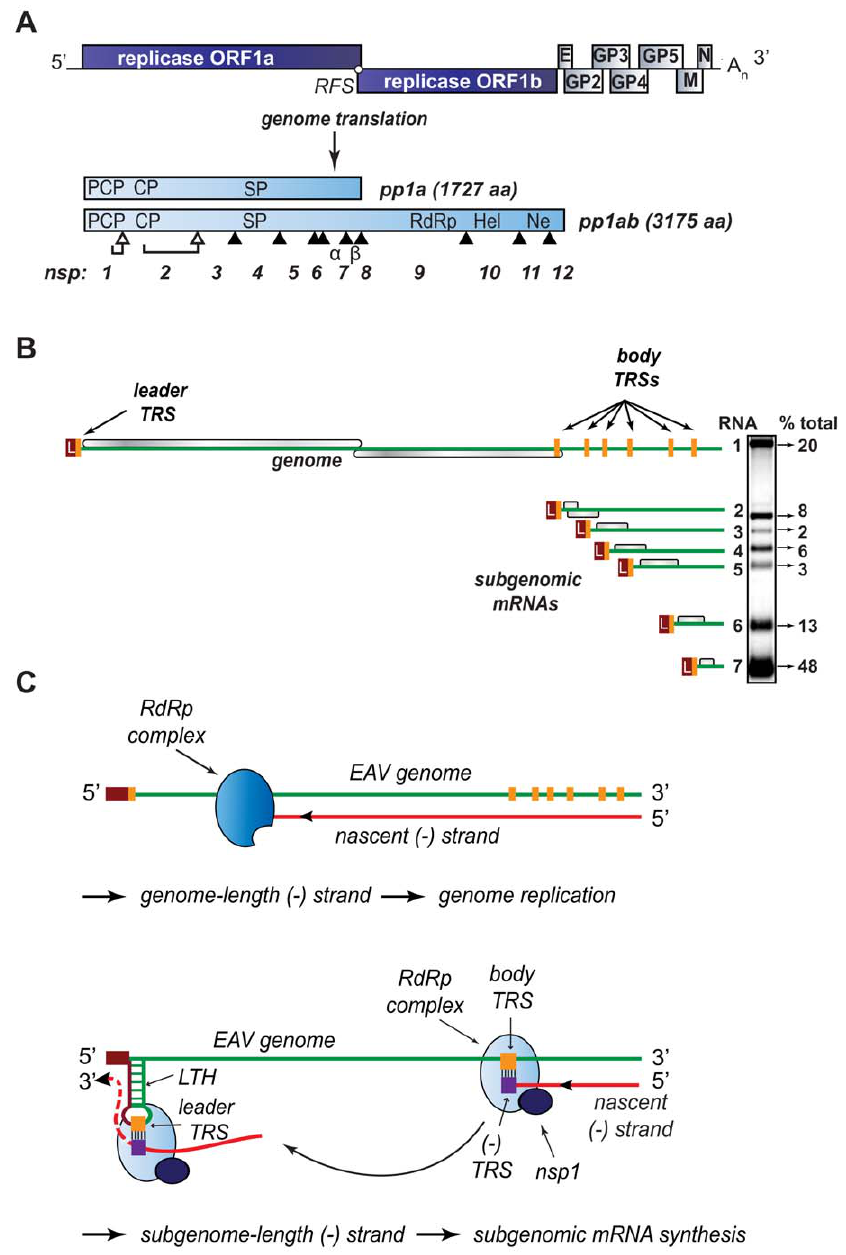
Figure 1. Organization and expression of the polycistronic EAV + RNA genome. (A) Top: EAV genome organization, showing the 5 9 - proximal replicase open reading frames (ORFs), as well as the downstream ORFs encoding the viral structural proteins envelope (E), membrane (M), nucleocapsid (N), and glycoproteins (GP) 2–5 and the 3 9 poly(A) tail (A n ). Bottom: overview of the pp1a and pp1ab replicase polyproteins that result from genome translation, which requires an ORF1a/1b ribosomal frameshift (RFS) to produce pp1ab. Arrowheads represent sites cleaved by the three virus-encoded proteases (open for autoproteolytically processed ones, closed for sites processed by the main proteinase in nsp4). The resulting nonstructural proteins (nsp) are numbered. The key viral enzymatic domains such as the nsp1 papain-like cysteine proteinase b (PCP), nsp2 cysteine proteinase (CP), nsp4 serine proteinase (SP), nsp9 viral RNA-dependent RNA polymerase (RdRp), nsp10 helicase (Hel), and nsp11 endoribonuclease (Ne) are indicated. (B) Overview of viral mRNA species produced in EAV-infected cells. The ORFs expressed from the respective mRNAs are shown in gray, and the 5 9 leader sequence is depicted in dark red. The orange boxes indicate the positions of transcription-regulating sequences (TRS). The gel hybridization image on the right is representative of the wild-type accumulation levels of the seven EAV mRNAs at the time point used for analysis in the study (see text for details). The amount of each mRNA, determined by quantitative phosphorimager analysis, is indicated as percentage of the total amount of viral mRNA. (C) Model for EAV replication and transcription. Continuous minus-strand RNA synthesis yields a genome-length minus strand template for genome replication, a process for which nsp1 is dispensable. Discontinuous minus-strand RNA synthesis results in a nested set of subgenome-length minus strands that serve as templates for sg mRNA synthesis (see text for details). Nsp1 is crucial for this process, which is also guided by a base pairing interaction between the TRS complement [( 2 )TRS] at the 3 9 end of the nascent minus-strand and the genomic leader TRS, present in a RNA hairpin structure (LTH).